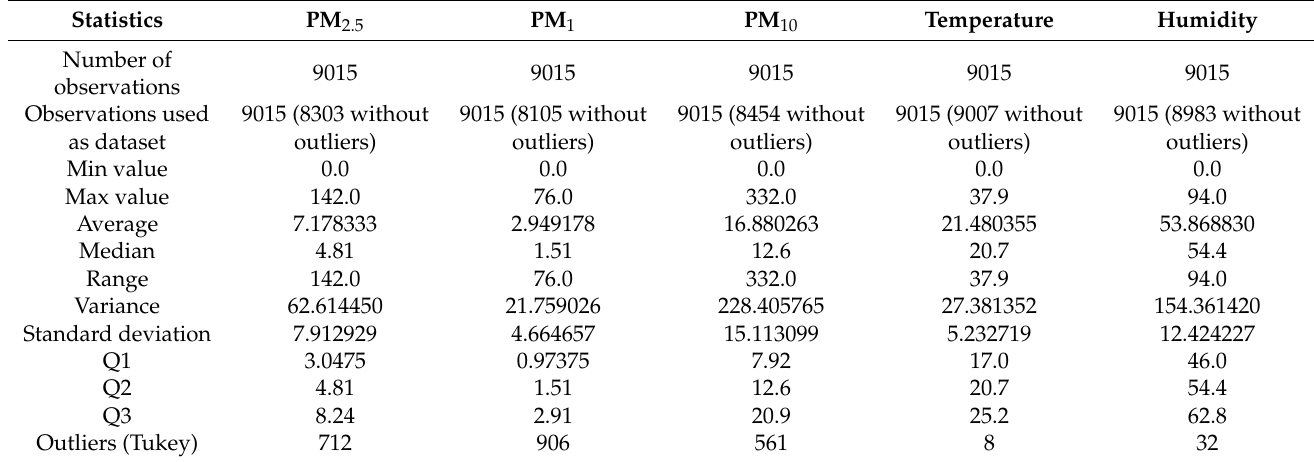
Table 5. Statistical details of the particulate matter measuring device #